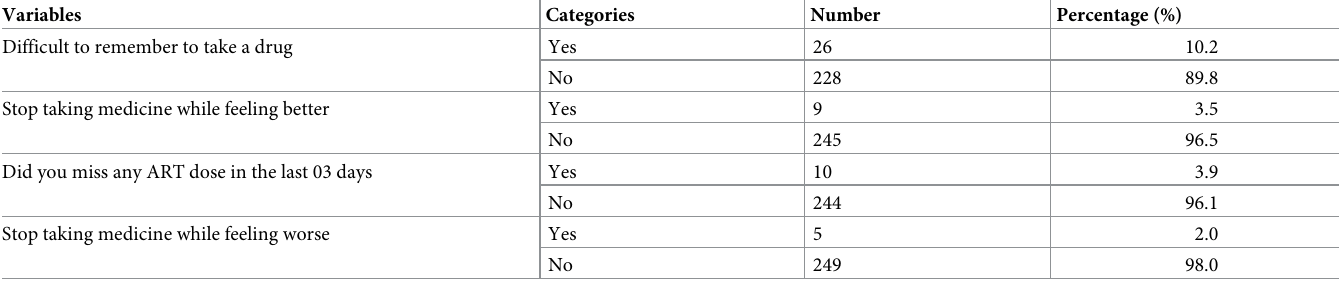
Table 3. The adherence questions and the answers given among pregnant & lactating mothers in selected governmental health facilities of Hawassa city, Southern Ethiopia, 2019/20 G.C.